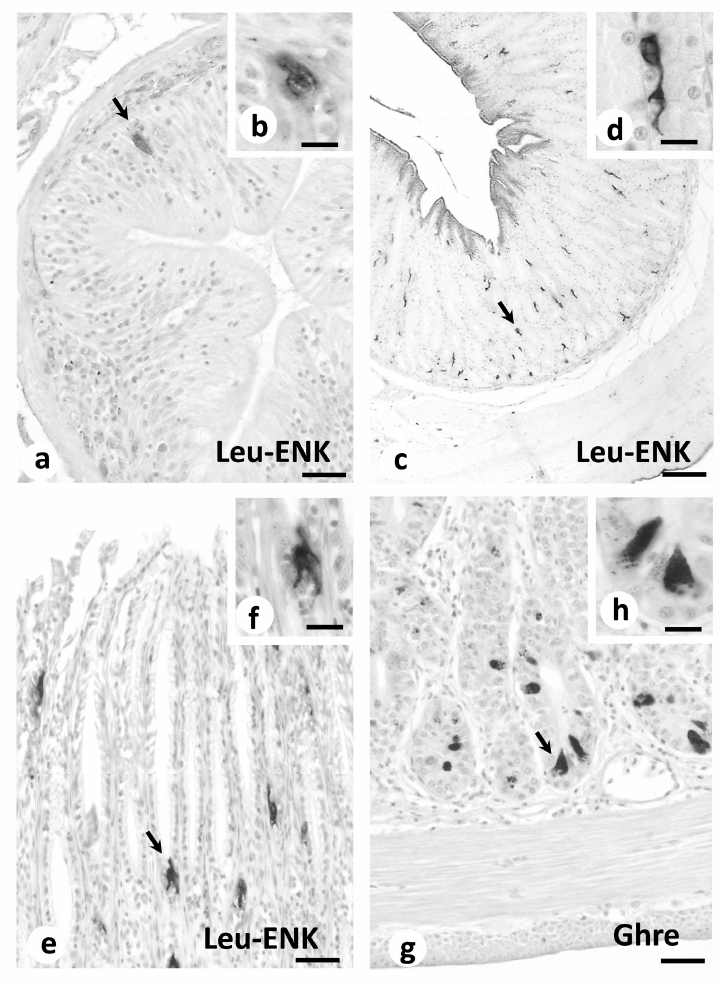
Figure 2. Comparative photomicrographs of Prochilodus lineatus digestive tract endocrine cells. – a and b. Pyloric caeca presenting closed-type Leu-ENK- IR endocrine cells (arrow). – c and e. Leu-ENK-IR endocrine cells located surrounding the gastric glands (arrow). – d, f, and h. High- power magnification showing different IR endocrine cells. – g. Ghre-IR endocrine cells observed in the epithelium of the glandular intestine (arrow). Scale bars: low- power magnification views = 30 µm; insets = 10